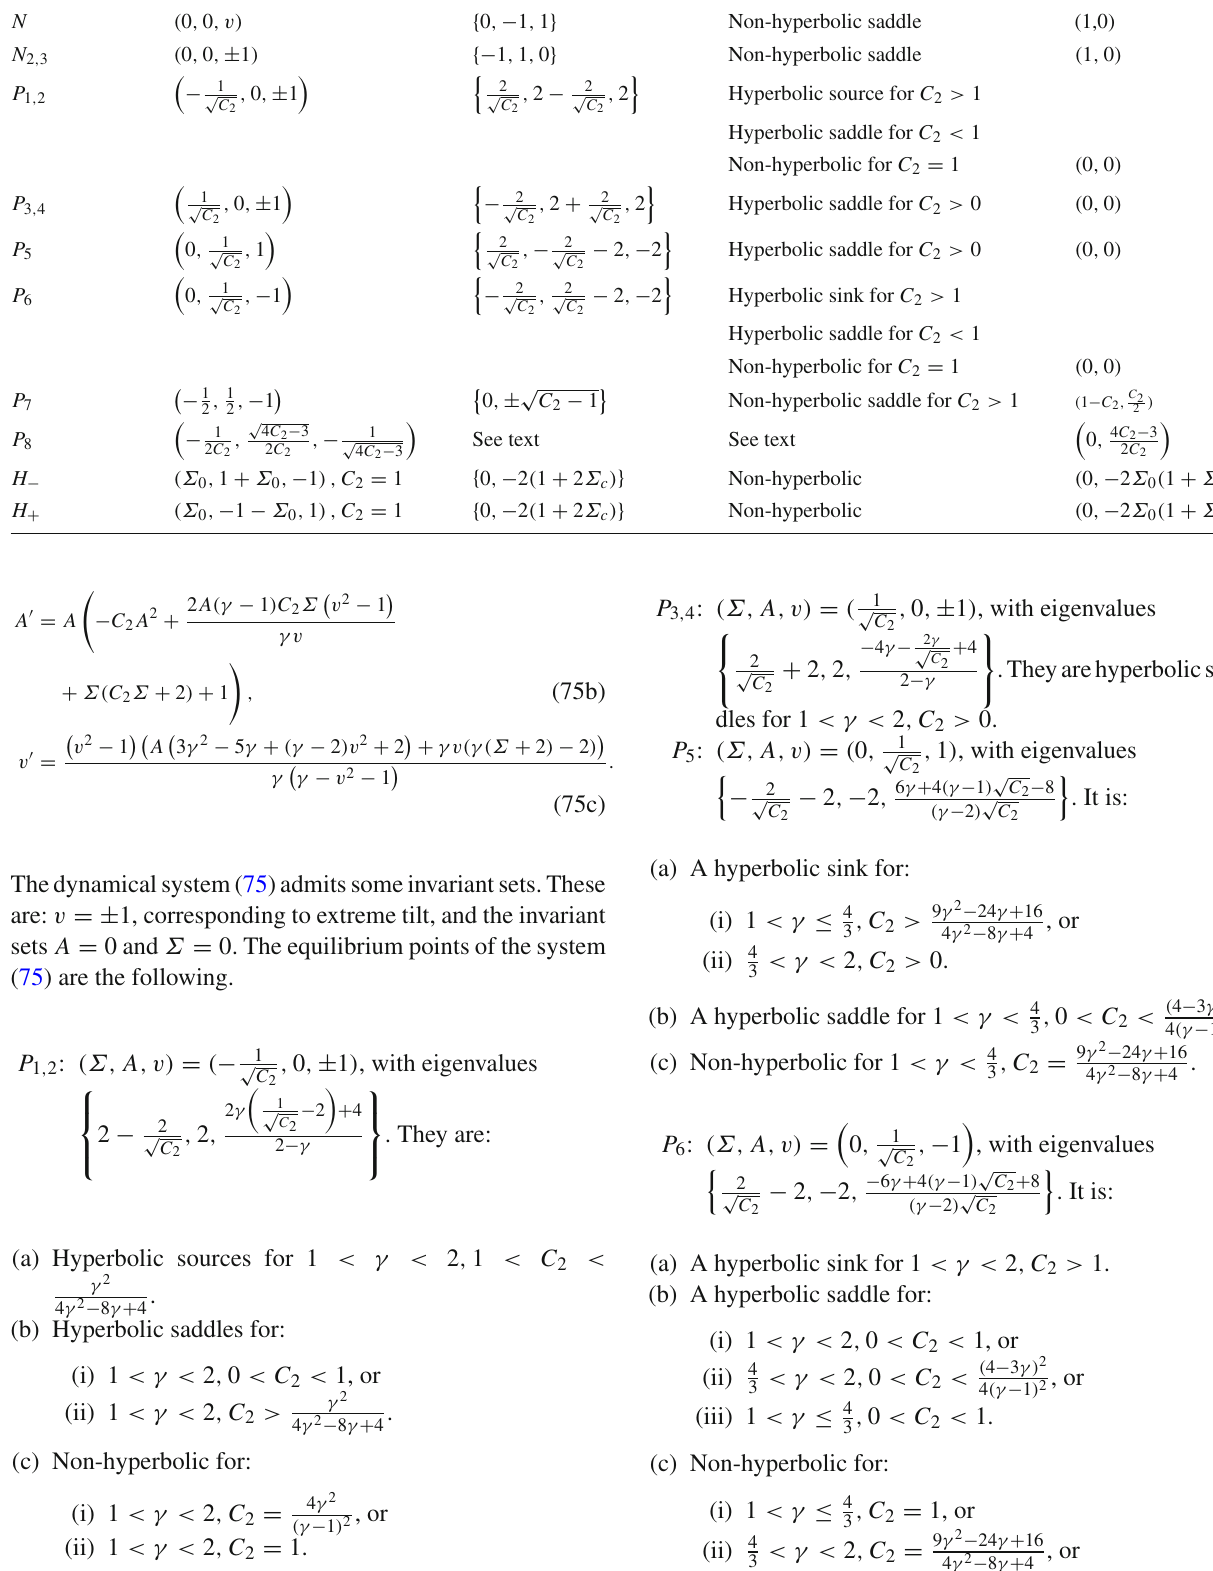
Table 2 Qualitative analysis of the equilibrium points of system (72) for a pressureless fluid ( γ = 1) and v (cid:12)= 0. Line N is included Equil.